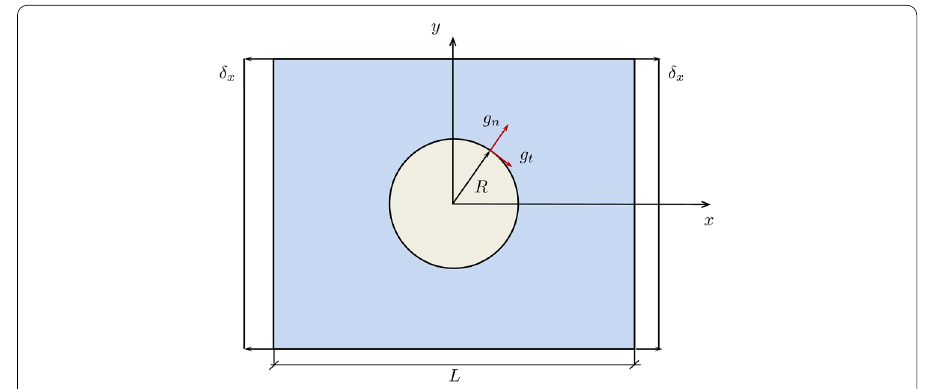
Fig. 18 Micromechanics of fibre reinforced composite materials: geometry and boundary conditions